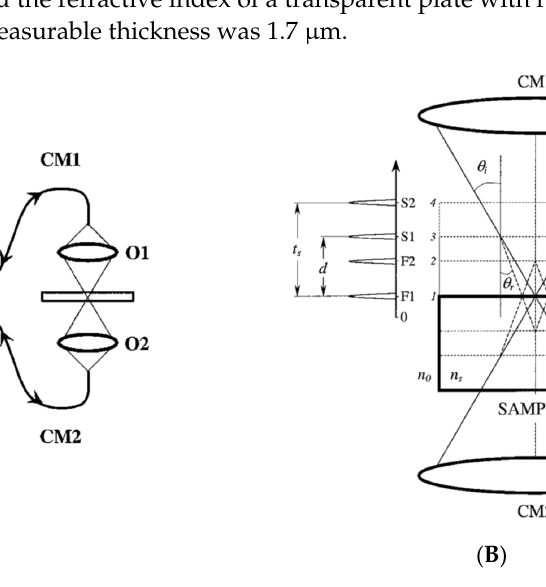
8 of 20 Figure 7. ( A ) Schematic of optical fixed ‐ angle reflectometry and ( B ) graphical determination of mean